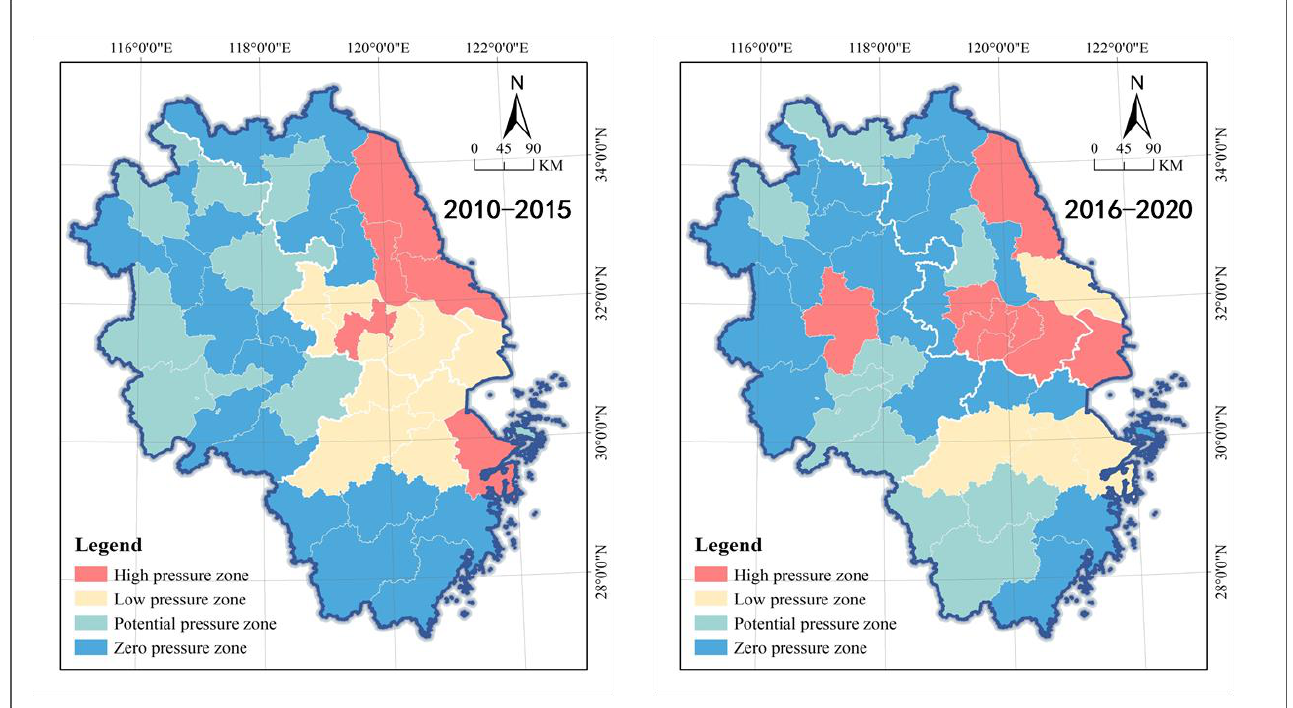
Figure 5. Analysis on the risk zoning of real estate inventory in Yangtze River Delta.